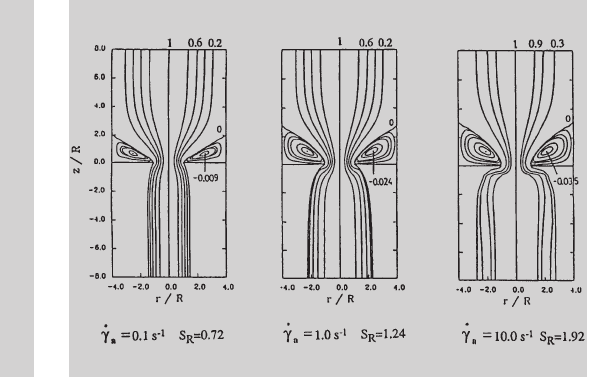
Figure 2 (left): Model predictions of shear viscosity η S , first normal stress difference N 1 , and extensional viscosities η η E (uniaxial), B (biaxial), η P (planar), for the IUPAC-LDPE melt (sample A) using the K-BKZ model with the material parameters given in Table 1. Symbols are experimental data reported by Meissner [12]. Figure 3: Streamline patterns at different apparent shear rates or stress ratios (see Eq. 8) for the flow of the IUPAC-LDPE melt at 150 ° C through a 4:1 axisymmetric contraction and a capillary die with L/R = 0 (orifice)